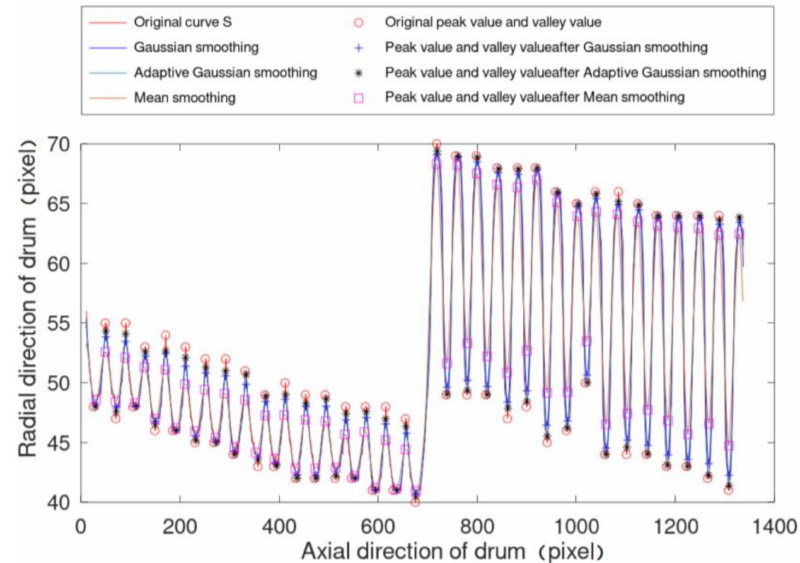
Figure 8. Peak value and valley value of curve S after filtering by three methods in frame 1. The original peak value and valley value are manually annotated.